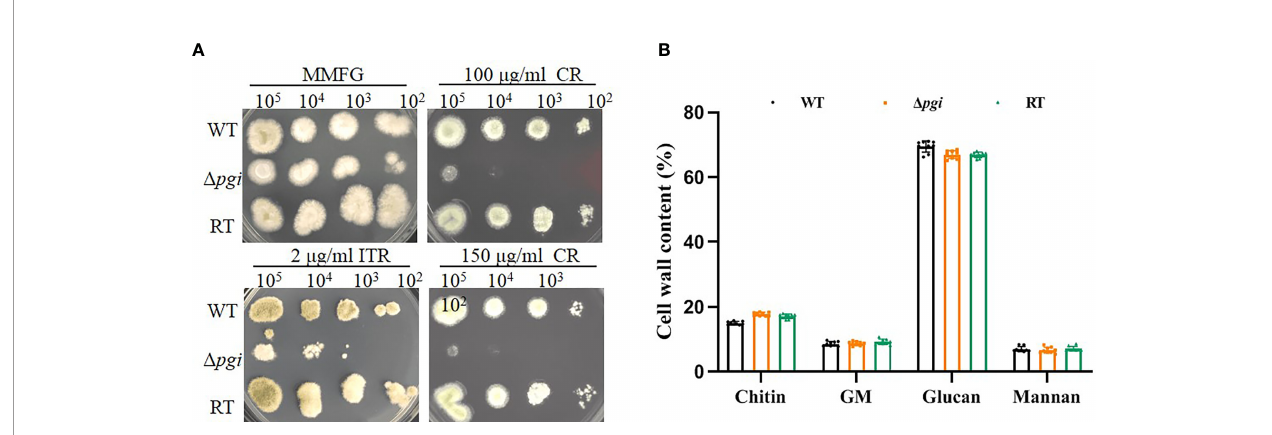
FIGURE 3 | Cell wall analysis of the D pgi mutant. (A) 10 2 – 10 5 conidia of the WT, D pgi , and RT strains were grown on MMFG supplemented with 2 m g/ml ITR, 100 and 150 m g/ml CR at 37°C for 48 h; (B) 10 5 conidia were inoculated into 100 ml liquid MMFG and incubated at 37°C for 48 h. Ten milligrams of dry mycelia was used for quanti fi cation of the cell wall contents. Three biological replicates